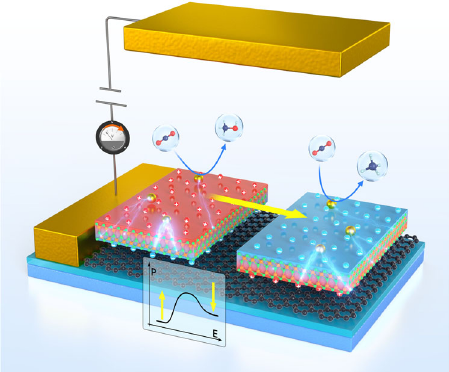
Fig. 6 Schematic diagram of ferroelectric controllable CO 2 RR. Here, metal anchored α -In 2 Se 3 monolayer is placed between the electrodes to achieve ferroelectric switching and controllable catalysis, tuned by the reversal of the bias